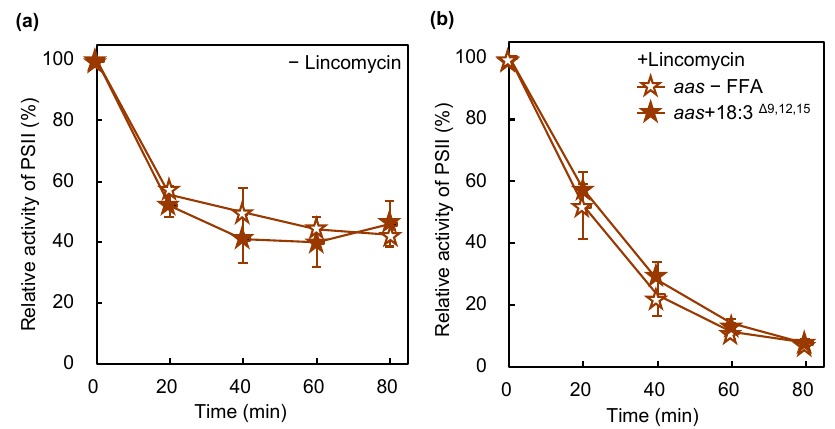
Figure 7. Effect of 18:3 ∆ 9,12,15 on the photoinhibition of PSII in an AAS-lacking mutant. aas cells in the absence (brown empty stars) or presence (brown filled stars) of 50 µ mol L − 1 18:3 ∆ 9,12,15 were incubated at 32 ◦ C under light at 1500 µ mol photons m − 2 s − 1 with ambient aeration in the absence ( a ) and presence ( b ) of lincomycin. The 18:3 ∆ 9,12,15 was supplemented at a final concentration of 50 µ mol L − 1 just before the onset of illumination. The activity of PSII was monitored in terms of the evolution of oxygen in the presence of 1 mmol L − 1 1,4-benzoquinone as the electron acceptor. Values are the means ± SD (bars) of three independent